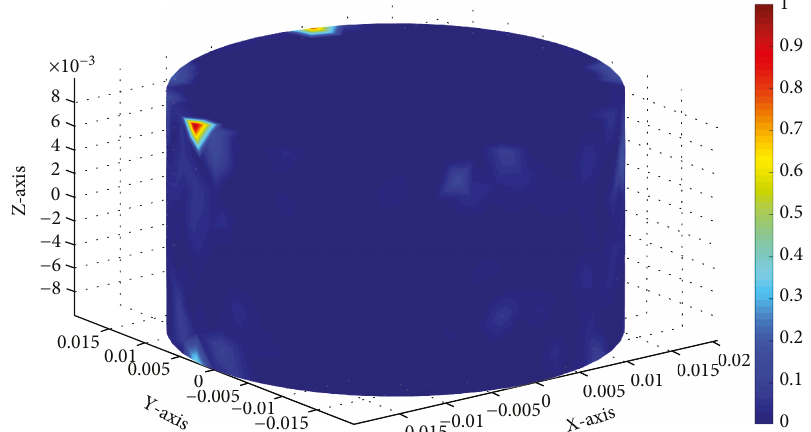
Figure 13: The amplitude distribution of the tangential modal electric fi eld corresponding to the modal current shown in Figure 12. Here, the light triangles in this fi gure originate from numerical calculation